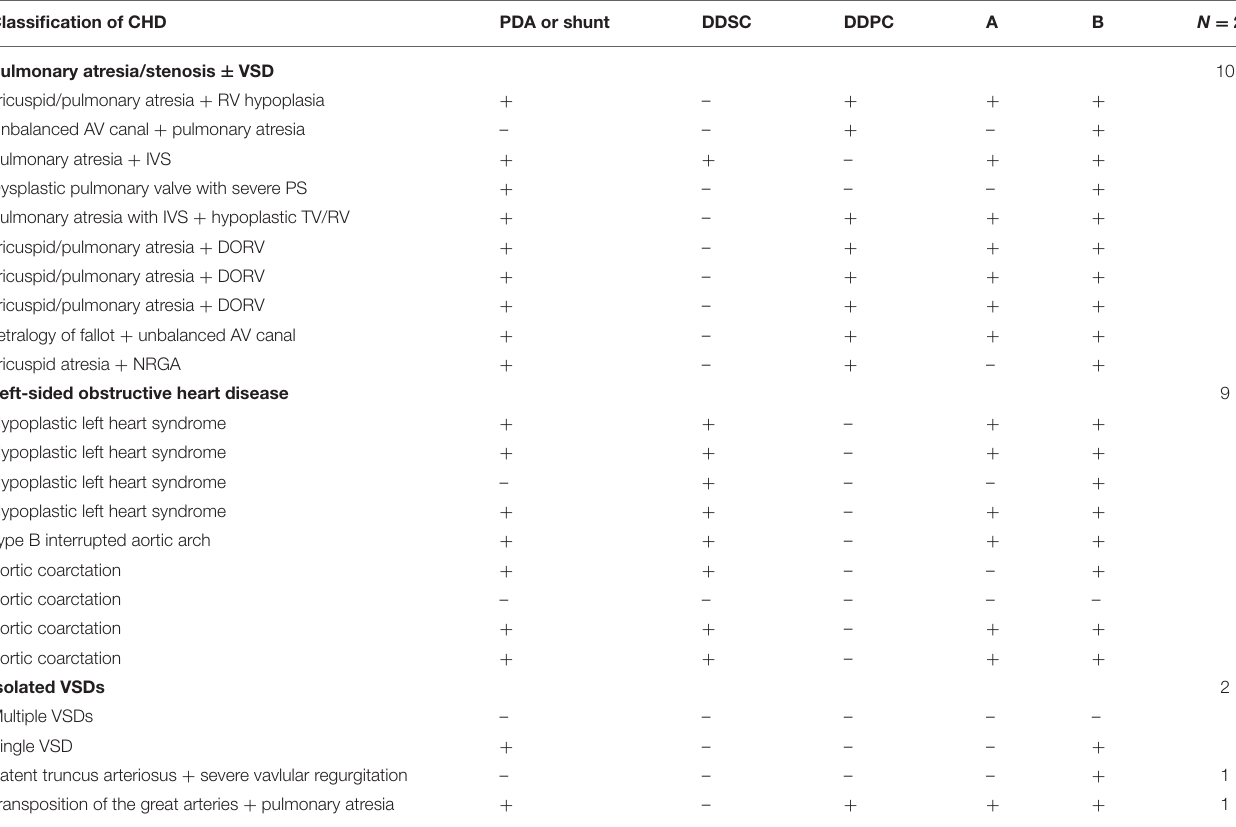
TABLE 2 | Types of congenital heart disease. Classification of